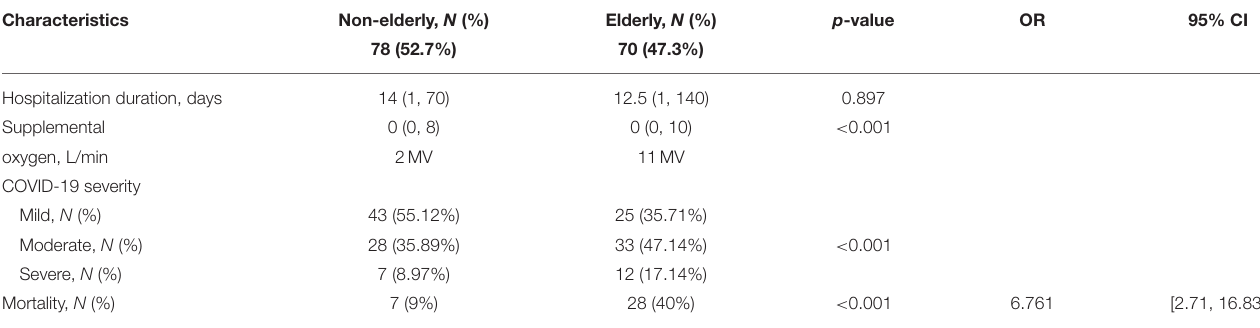
TABLE 4 | Clinical outcome of patients.